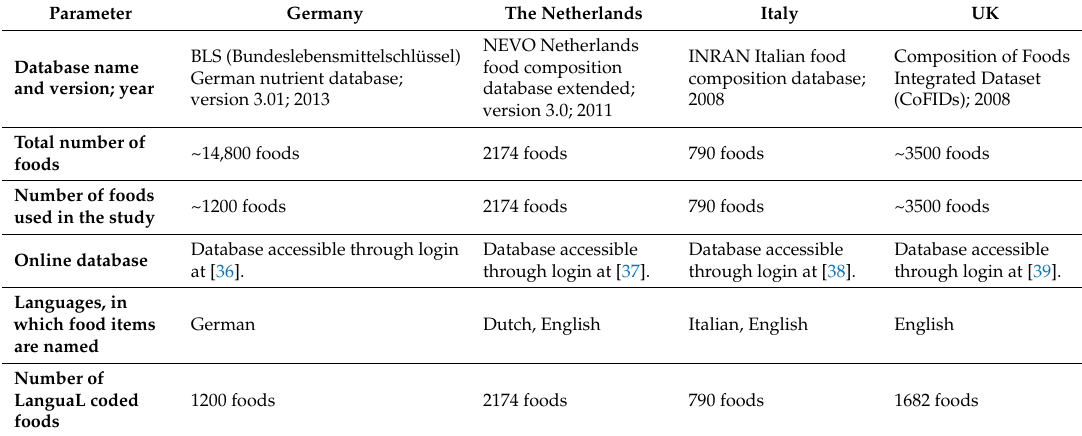
Table 2. Characteristics of the food composition databases, available in the EuroFIR information platform (except BLS) and used for training purposes. Since the study, presented in the paper, these characteristics have changed. Interested readers can find more details on the EuroFIR’s website